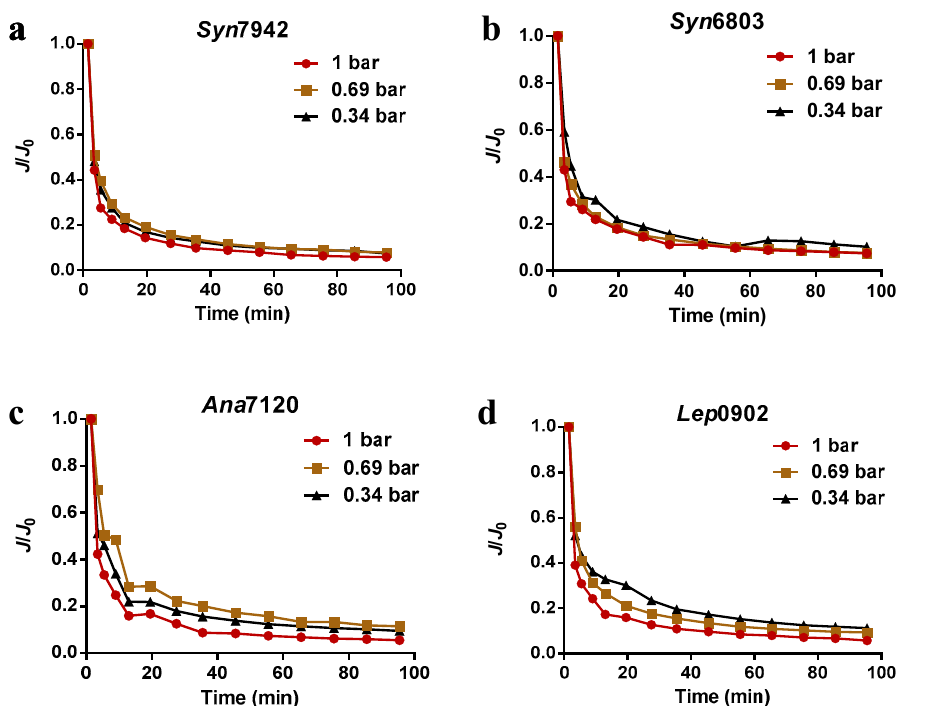
Figure 2. The normalized fluxes of the four species of cyanobacteria at different test pressures over time; ( a ) Syn 7942; ( b ) Syn 6803; ( c ) Ana 7102; ( d ) Lep 0902. The membrane investigated here was an MF (010), and the OD730 of cyanobacteria used for filtration was 1.5–1.8.